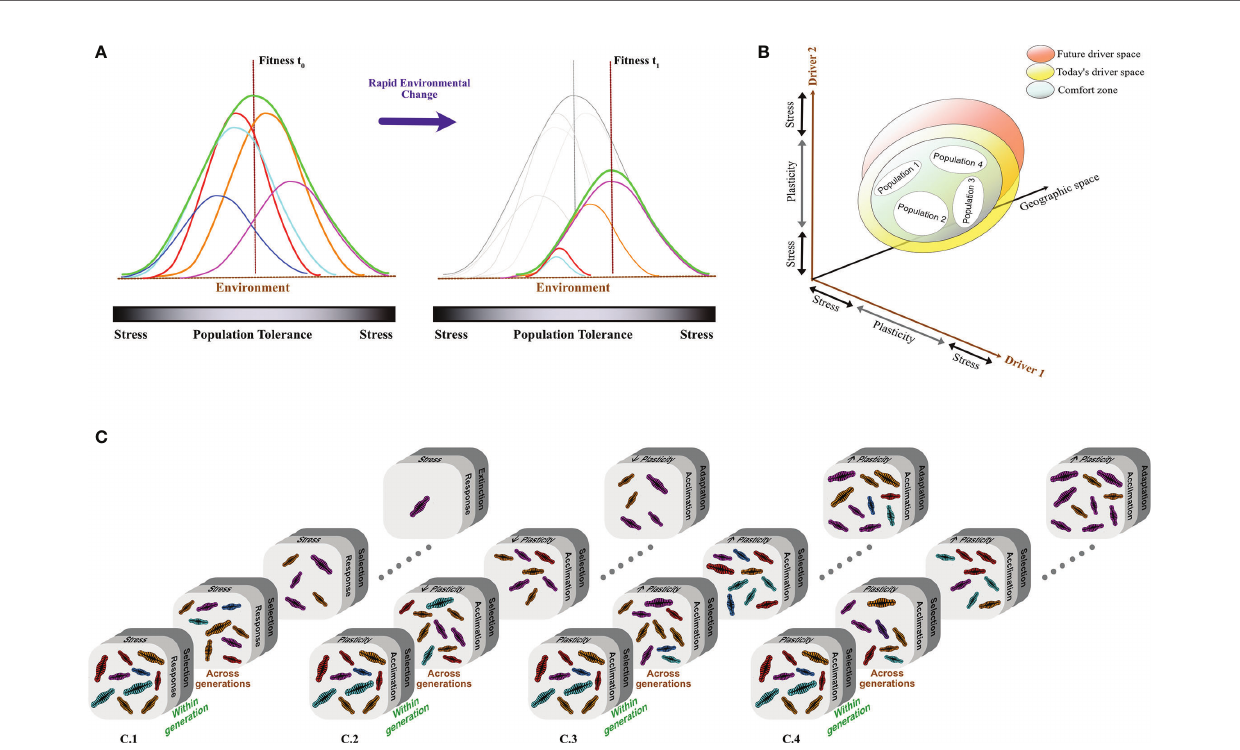
FIGURE 1 | Ecological and evolutionary dynamics of marine microbial organisms in variable and dynamic oceans. (A) The overall fi tness of a population (green curve) is a function of the tolerances and capacity for plastic adjustments of individual genotypes/strains (colour curves). This function determines the adaptive capacity of a population to persist after rapid environmental changes. (B) These changes involve more than one driver at the time. In a population, the balance between tolerances, plasticity and stress for each driver determines its ecological niche and helps to predict the capacity to respond to future environmental changes. Different populations can be locally adapted as result of differences in the environmental conditions and the variability they experience. This can explain the geographic differences in the capacity for phenotypic plasticity and adaptive potential (e.g., narrower or closer to their tolerance limits). (C) Populations with contrasting differences in the capacity for plastic adjustments, tolerances and potential for adaptive evolution in response to environmental changes show divergent ecological and evolutionary dynamics (within and across generations). Rapid reduction of genetic diversity and high extinction risk is expected for populations with limited phenotypic plasticity inhabiting stable environments where only one driver changes (C.1). If plasticity is present, it can buffer the in fl uence of selection mitigating population decline and extinction (C.2). Fluctuating environments are hypothesised to facilitate plasticity promoting the maintenance of phenotypic/genetic diversity as a consequence of reduced strength of directional selection (C.3). However, if multiple drivers are interacting and changing in these environments, selection is going to be stronger accelerating the fi xation of “ optimal ” phenotypes (more tolerant to directional changes in dominant drivers;